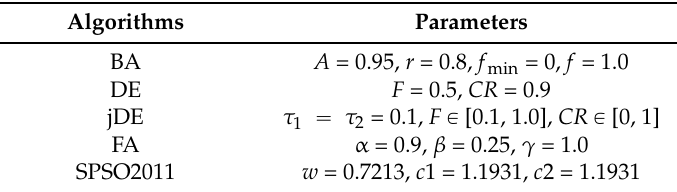
Table 8. Parameters of the algorithms.